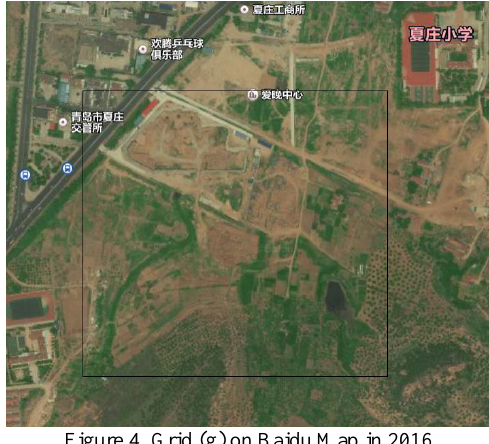
Figure 4. Grid (g) on Baidu Map in 2016 4.2 Distribution and autocorrelation of HVR With the experimental result, a map showing the HVR of residential grids in Qingdao is created (Figure 5).